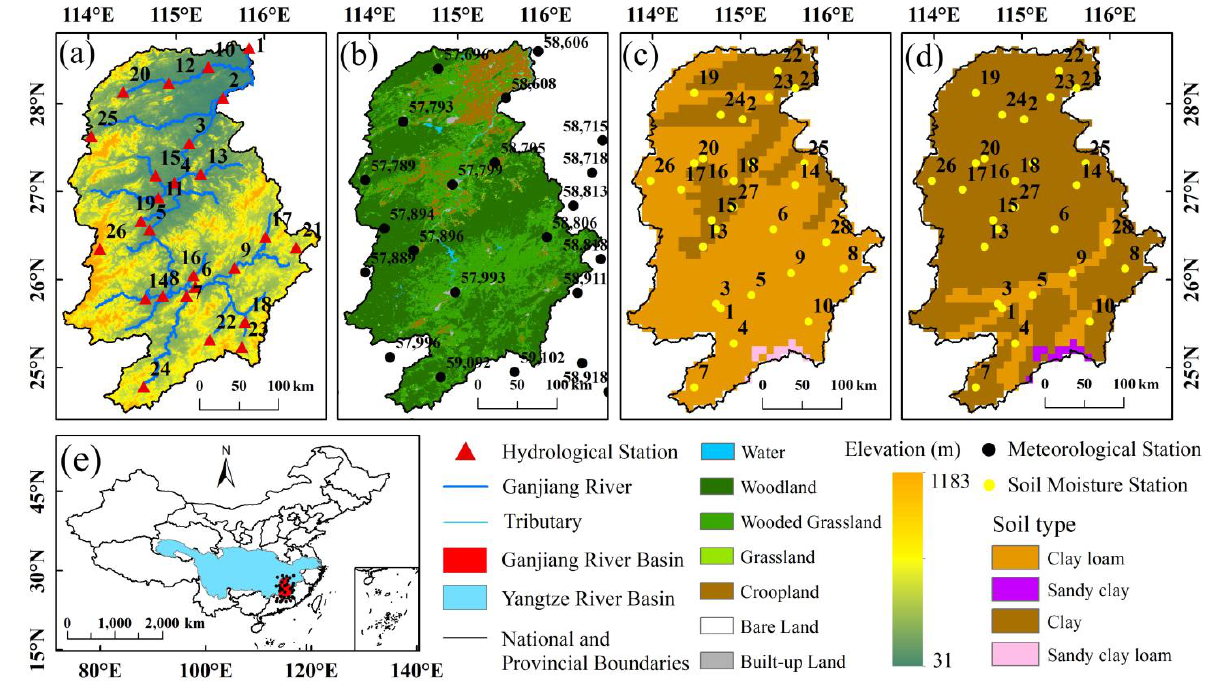
Figure 1. Maps of the Ganjiang River Basin (GRB) with ( a ) the spatial distribution of hydrological stations and the elevation, ( b ) the spatial distribution of meteorological stations and the main land- cover types, ( c ) the spatial distribution of soil moisture stations and soil texture of the first layer (0 – 30 cm), ( d ) soil texture of the second layer (30 – 100 cm), and ( e ) the location.